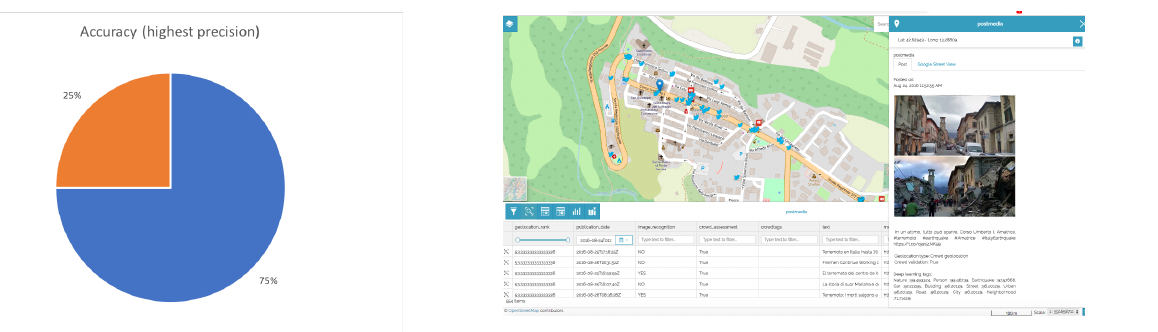
Figure 14. Copernicus Witness : Real time Visualisation of Social media data